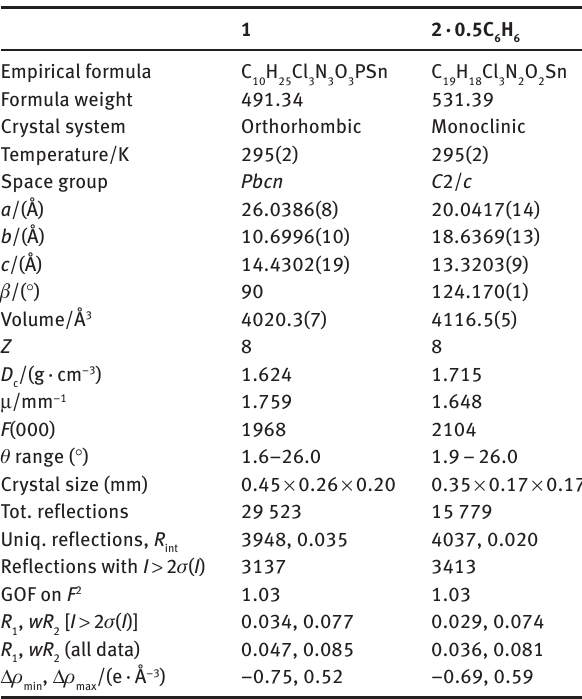
Table 2: Crystallographic data and structure refinements of 1 and H 2 · 0.5C 6 6